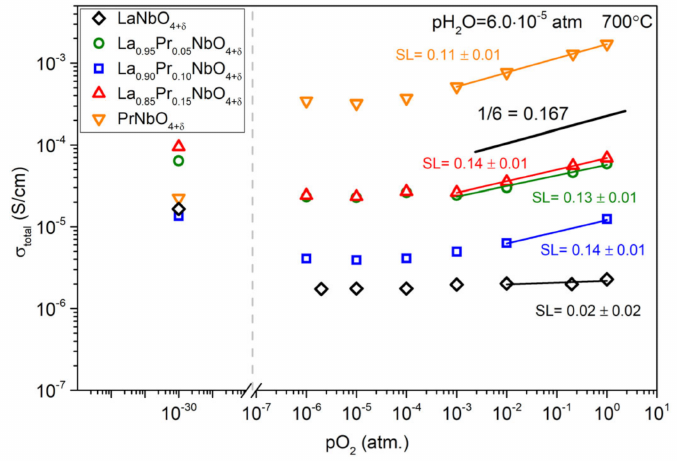
Figure 10. Total conductivity of La 1 − x Pr x NbO 4+ δ as a function of oxygen partial pressure in dry gases (pH 2 O = 6.0 × 10 − 5 atm) at 600 ◦ C. The SL denotes the slope coefficient of the log ( σ ) in a function of log (pO 2